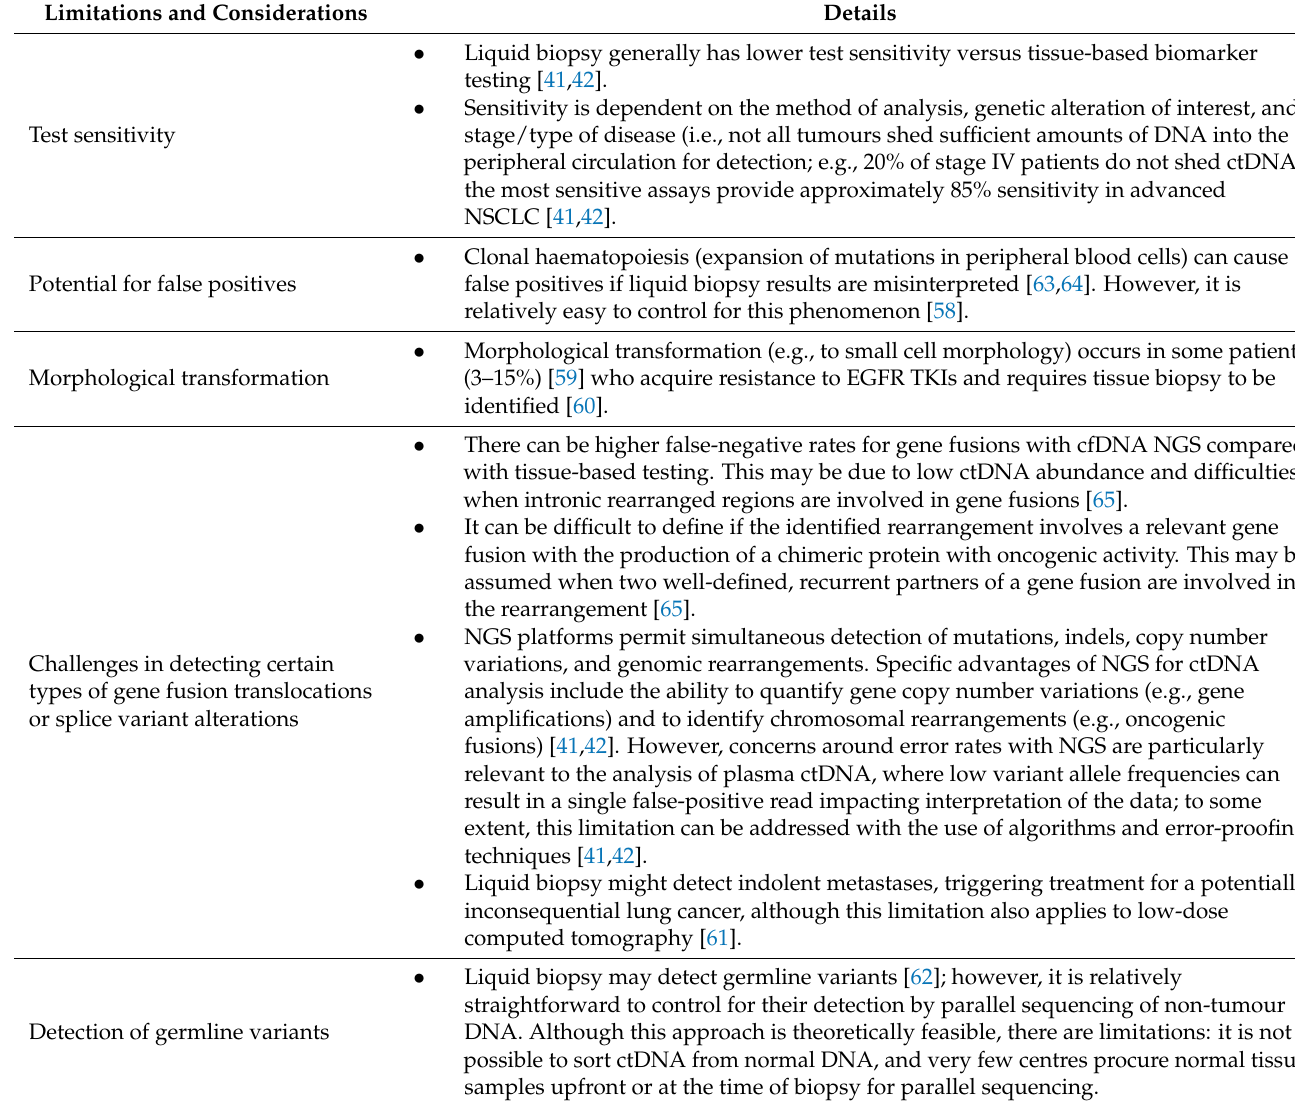
Table 3. Limitations and considerations for liquid